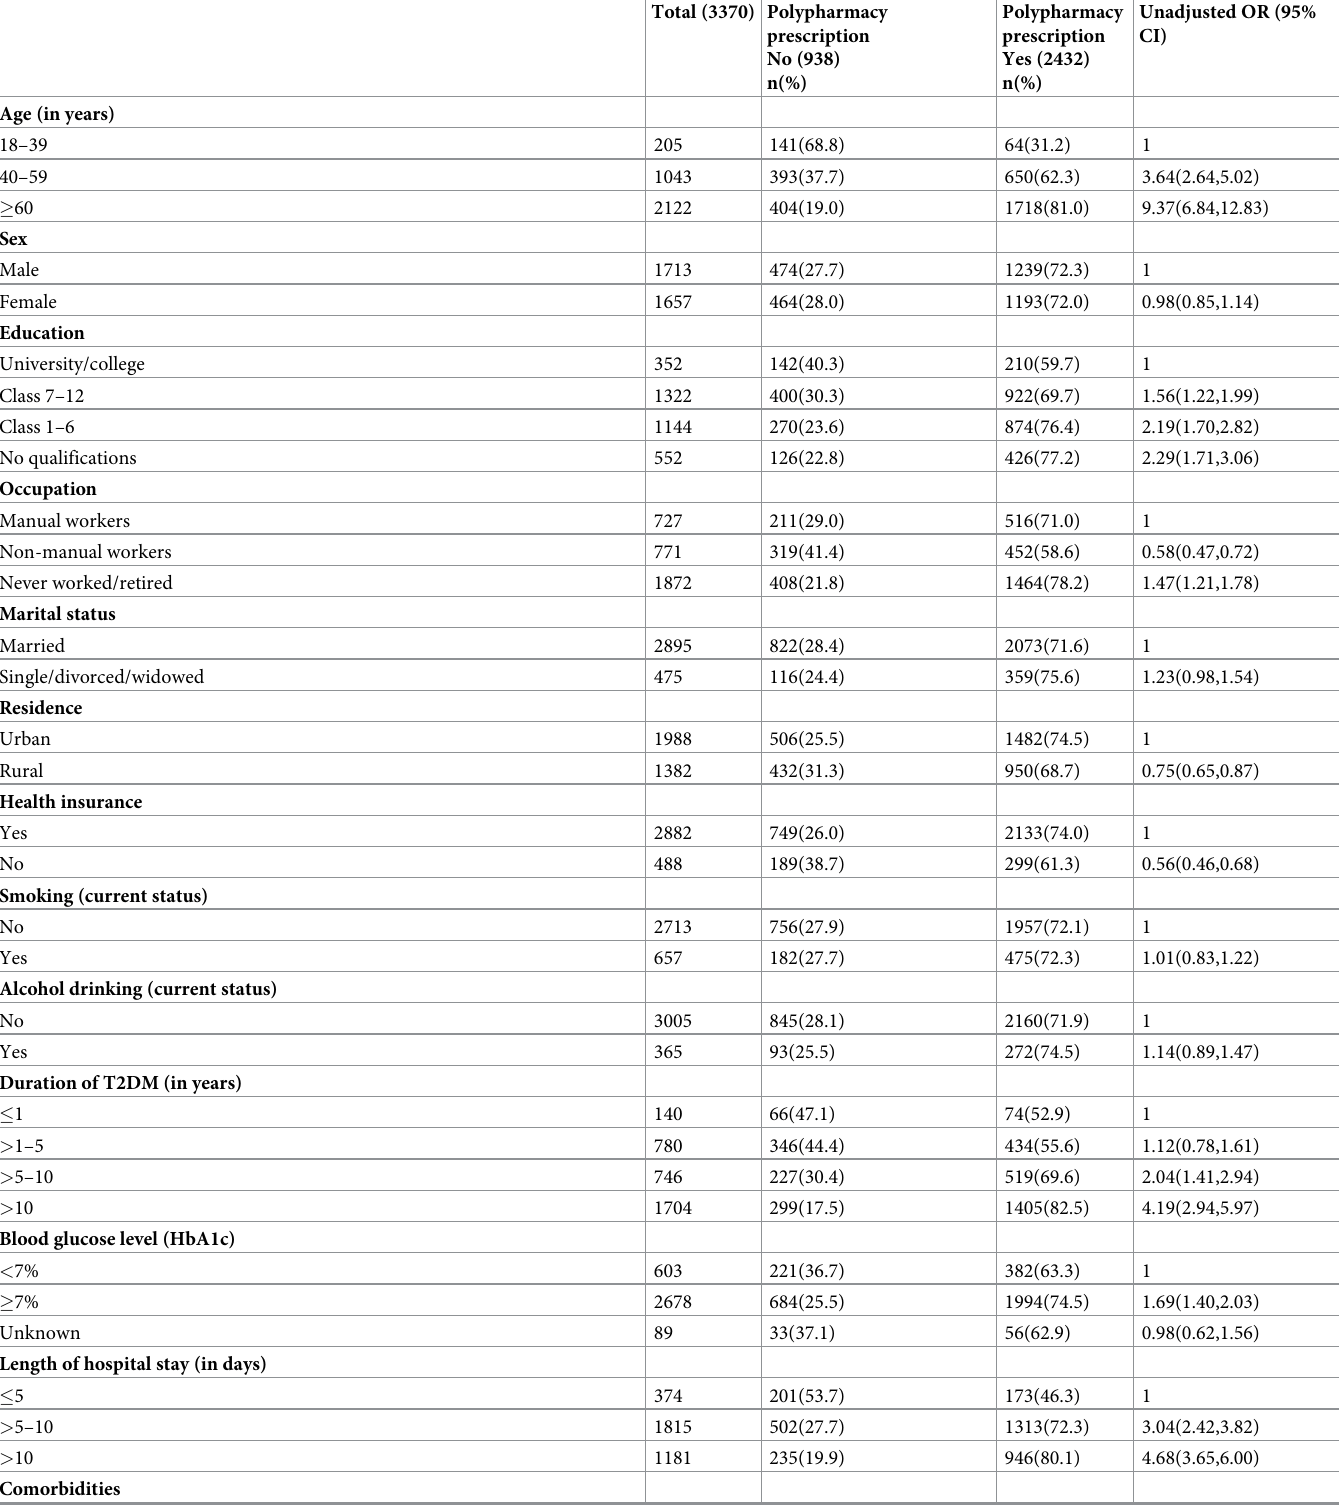
Table 2. Characteristics of T2DM patients with and without polypharmacy